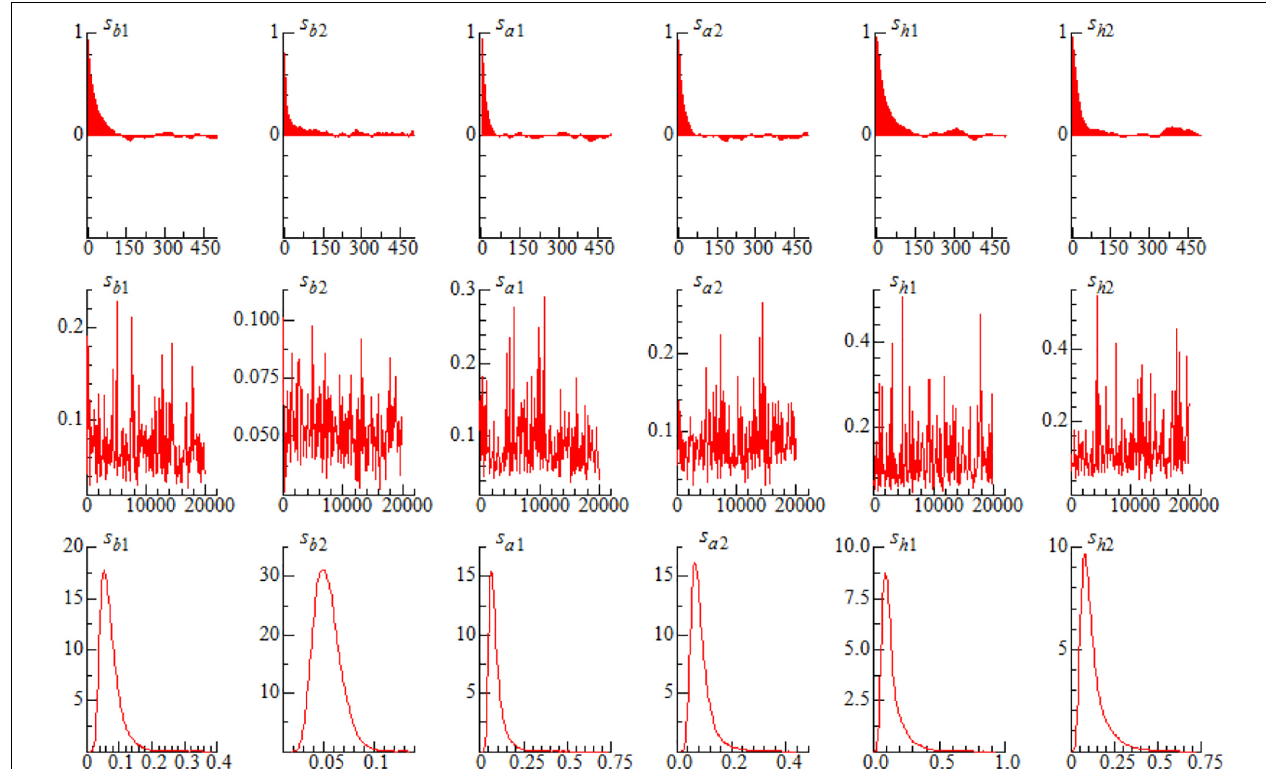
FIGURE 2 | Sample autocorrelations (top), sample paths (middle), and posterior densities (bottom).